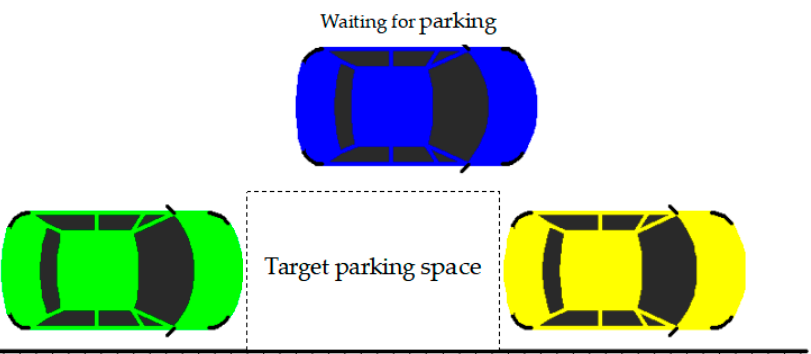
Figure 6. Schematic diagram of parallel parking condition.